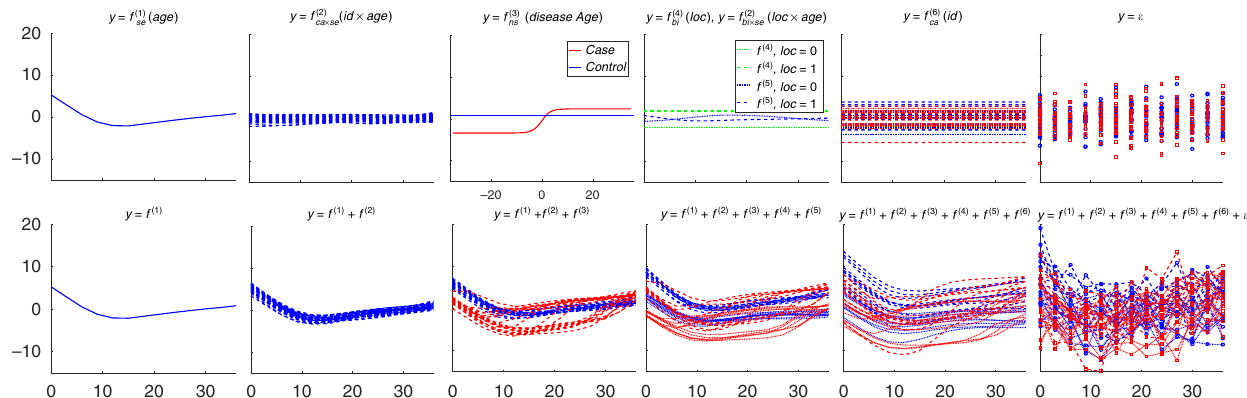
Fig. 1 An additive Gaussian process (Simulated data). The x -axis is age by default except for the third fi gure in the top panel, which is the disease age. The top panel shows random functions drawn from different components, i.e. GPs of the speci fi c kernels. The lower panel shows the cumulative effects of the different components. The bottom right panel shows the simulated